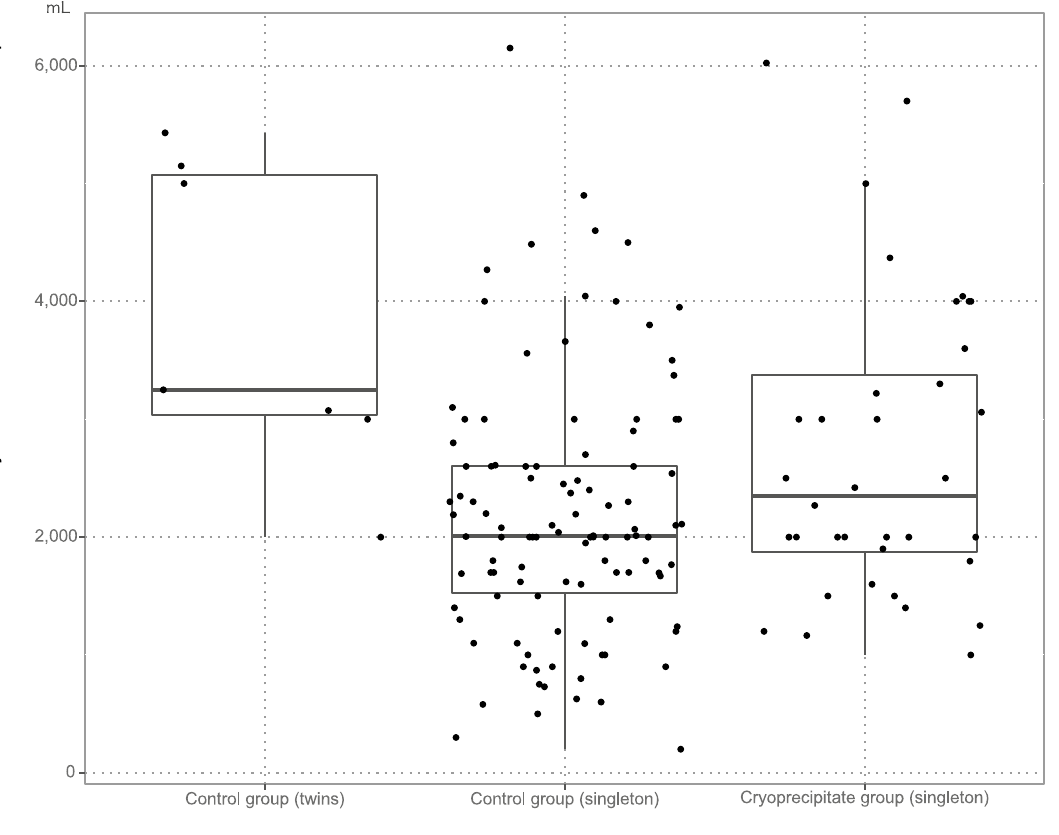
Figure 2. Estimated blood loss from delivery to the start of initial treatment at our hospital.